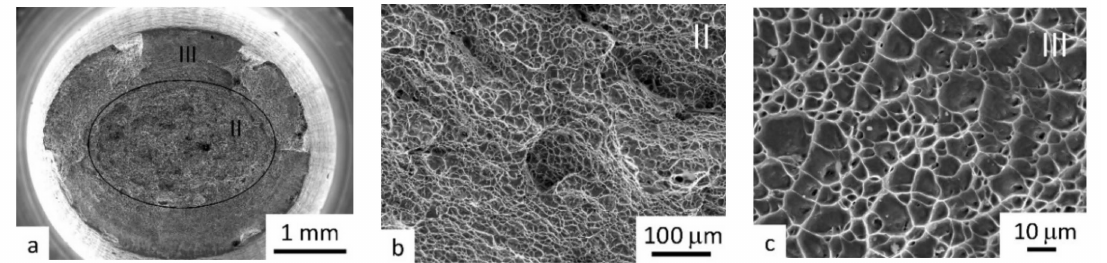
Figure 8. SEM images of the fracture surfaces of the samples after tests at a stress of 900 MPa, for the CG alloy: ( a ) general view of the fracture surface, ( b ) zone of accelerated crack growth (zone II), ( c ) final rupture zone (zone III).